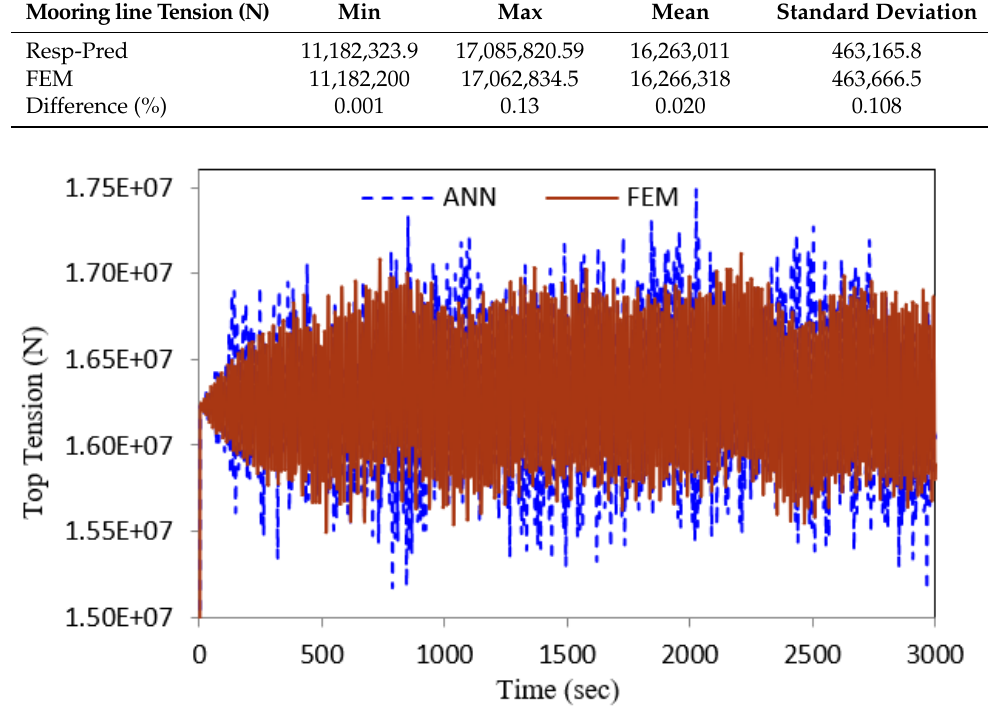
Figure 13. Top tension response time history predicted for 14.15 s wave period and 11.30 m wave height.